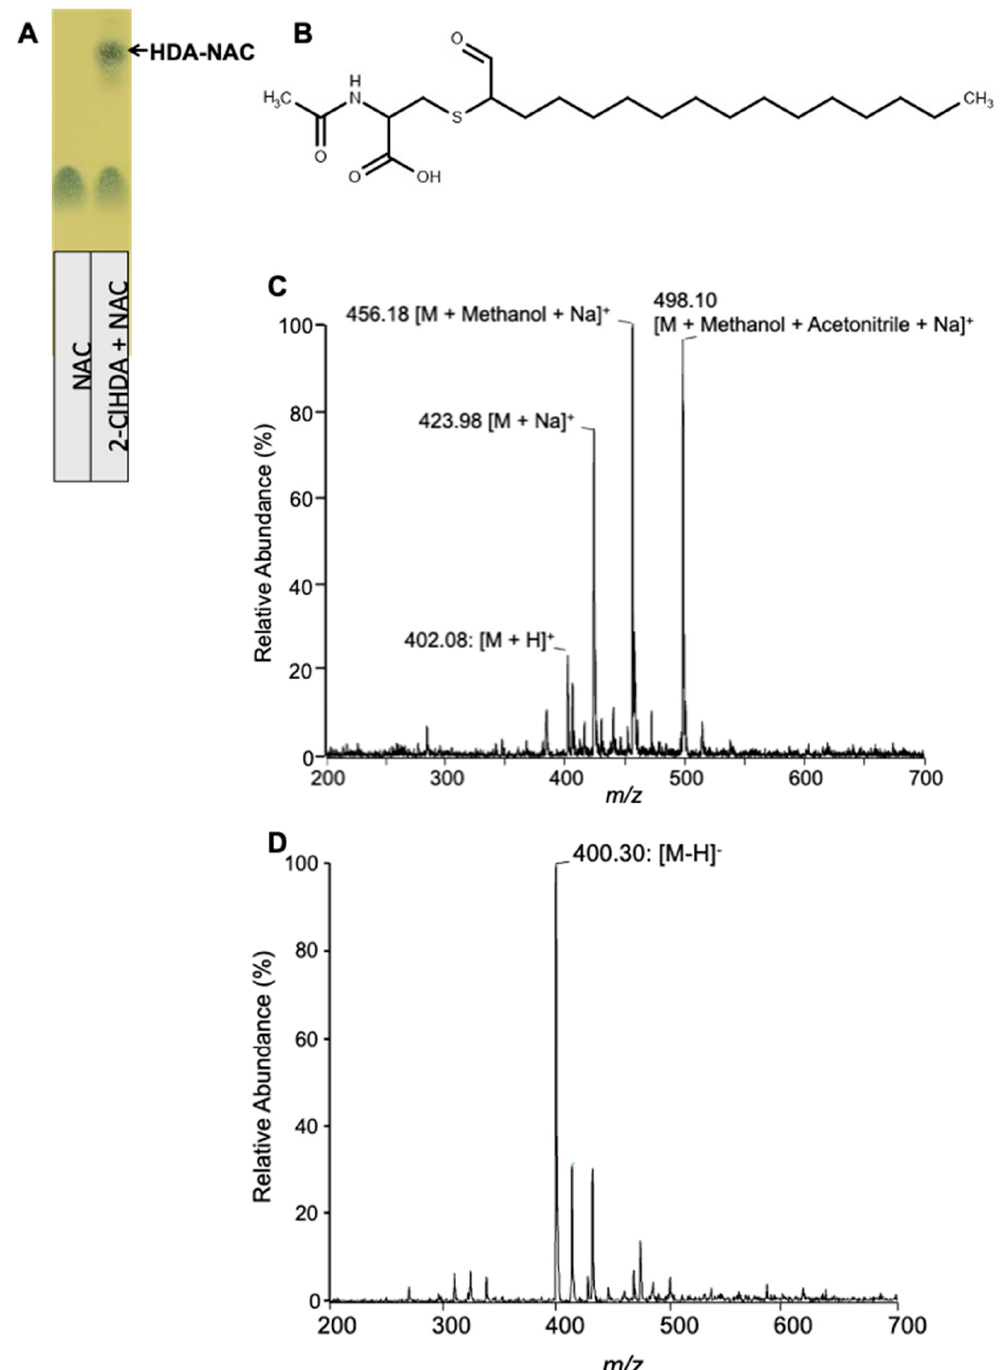
Figure 6. ESI/MS of TLC-purified 2-ClHDA adduct with NAC. The purity of the purified reaction product from 2-ClHDA incubations with NAC was confirmed by TLC and phosphomolybdic acid staining ( A ). ( B ) The putative molecular structure of the adduct HDA–NAC. The purified reaction product was analyzed by a positive ion ( C ) and negative ion ( D ) ESI/MS by direct infusion as described in “Materials and Methods”.